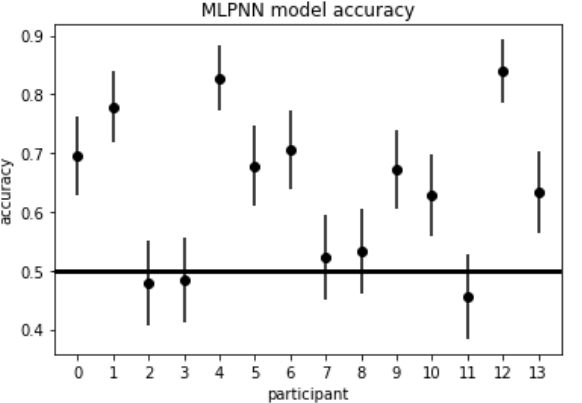
Figure 12. Participant validation accuracies for the MLPNN model, with 9 participants having validation accuracies statistically greater than random chance. Participants 2, 3, 7, 8, and 11 did not have validation accuracies greater than random chance. This model achieved a 7-fold CV accuracy of 64% (95% CI: 0.59,